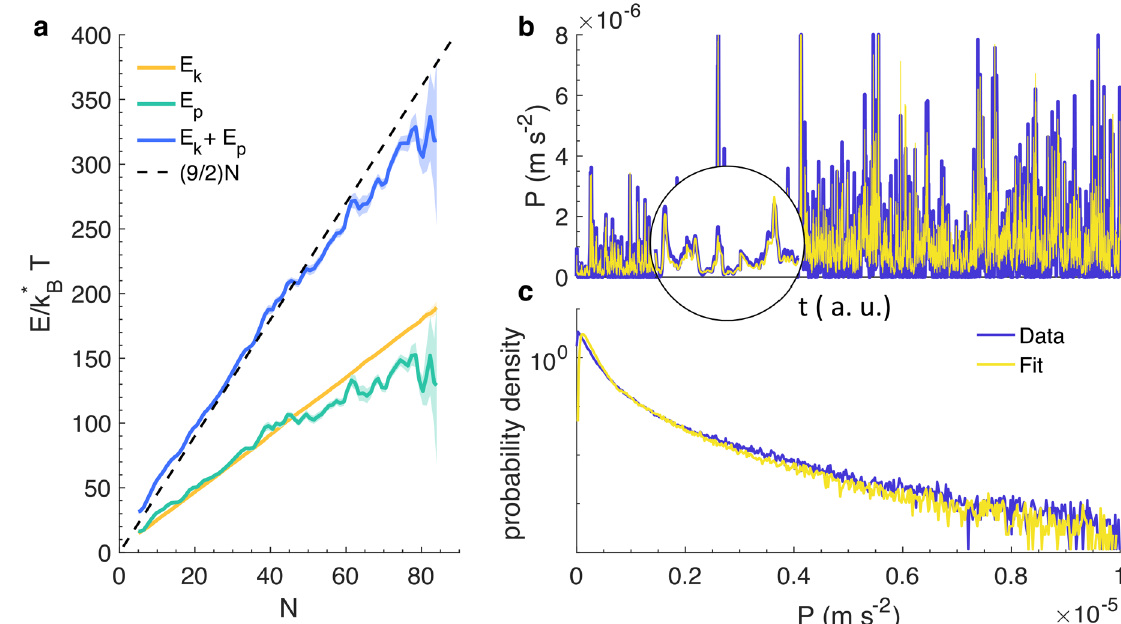
Figure 2. Equipartition and the equation of state. ( a ) The total energy of the system E normalized by k ∗ B T as a function of swarm size (blue) along with the kinetic energy E k (yellow) and potential energy E p (blue). The total normalized energy of the system is well approximated by (9/2) N (black dashed line), indicating that each individual midge contributes ( 9 / 2 ) k ∗ B T to E and thus has 9 degrees of freedom (6 after discounting the factor of ln2 in our definition of k ∗ B T ). The deviations from that behaviour for the largest swarms can be attributed to pressure from our equation of state. The inset shows a zoomed-in portion of the data to highlight the quality of the reconstruction. ( c ) PDF of the pressure for our entire data ensemble 23 . The statistics of the directly measured pressure (blue) and reconstructed pressure from the equation of state have nearly identical statistics for the full dynamic range of the